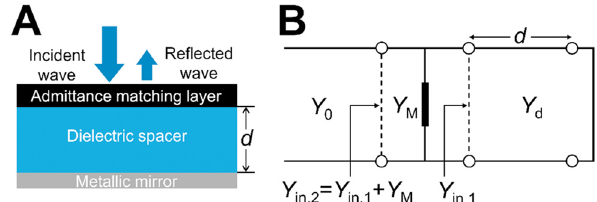
Figure 6: A basic absorber structure in section 3.1.1 with a single admittance matching layer and a corresponding equivalent transmissionlinemodel.(A)Abasicabsorberstructureis composed of three layers, which are an admittance matching layer, a dielectric spacer, and a metallic mirror. (B) An equivalent transmission line modelofthebasicabsorberstructure.Thethreelayersaremodelled with a shunt lumped element of admittance Y M , a segment of transmission line whose characteristic admittance ( Y d ) is same as theintrinsicadmittanceofthedielectricspacermaterial,andashort circuit, respectively. If the metallic mirror is not perfectly re fl ecting, it can be modelled with a fi nite lumped element admittance as